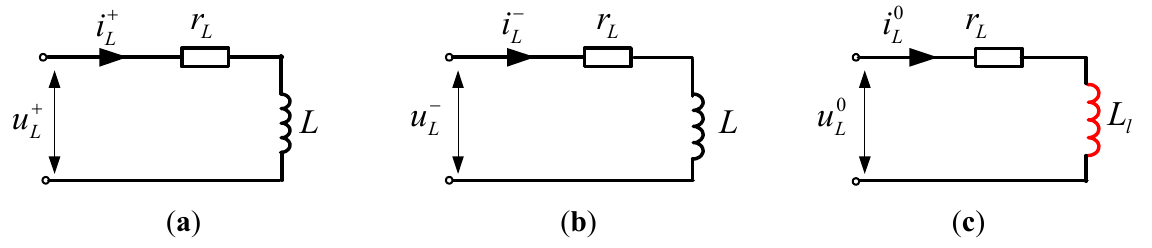
Figure 4. The ISC equivalent circuits for the three-limb inductor: ( a ) IPSC; ( b ) INSC; ( c )